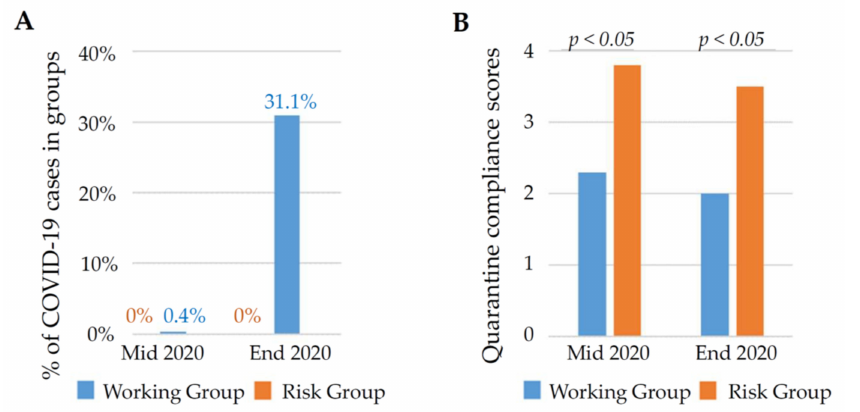
Figure 2. COVID-19 cases ( A ) and compliance with quarantine rules ( B ) in cohort groups during 2020 outbreak. For more information, see Supplementary Table S1.